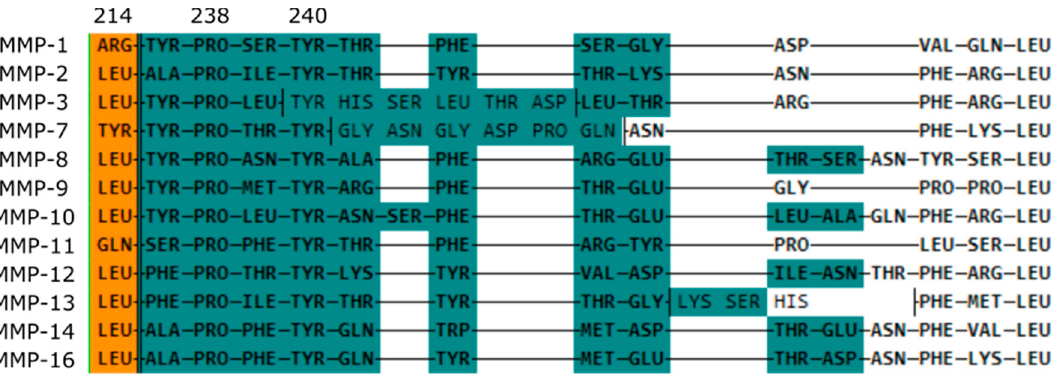
Figure 5. Sequence alignment of the S1’ pocket-forming residues of the MMPs, for which crystallographic data is available. (PDB IDs: MMP-1 1HFC [74], MMP-2 1QIB [75], MMP-3 1HY7 [76], MMP-7 2Y6D [77], MMP-8 1I76 [78], MMP-9 4XCT [79], MMP-10 3V96 [80], MMP-11 1HV5 [81], MMP-12 1Y93 [82], MMP-13 5B5O [83], MMP-14 3MA2 [84], MMP-16 1RM8 [85]).